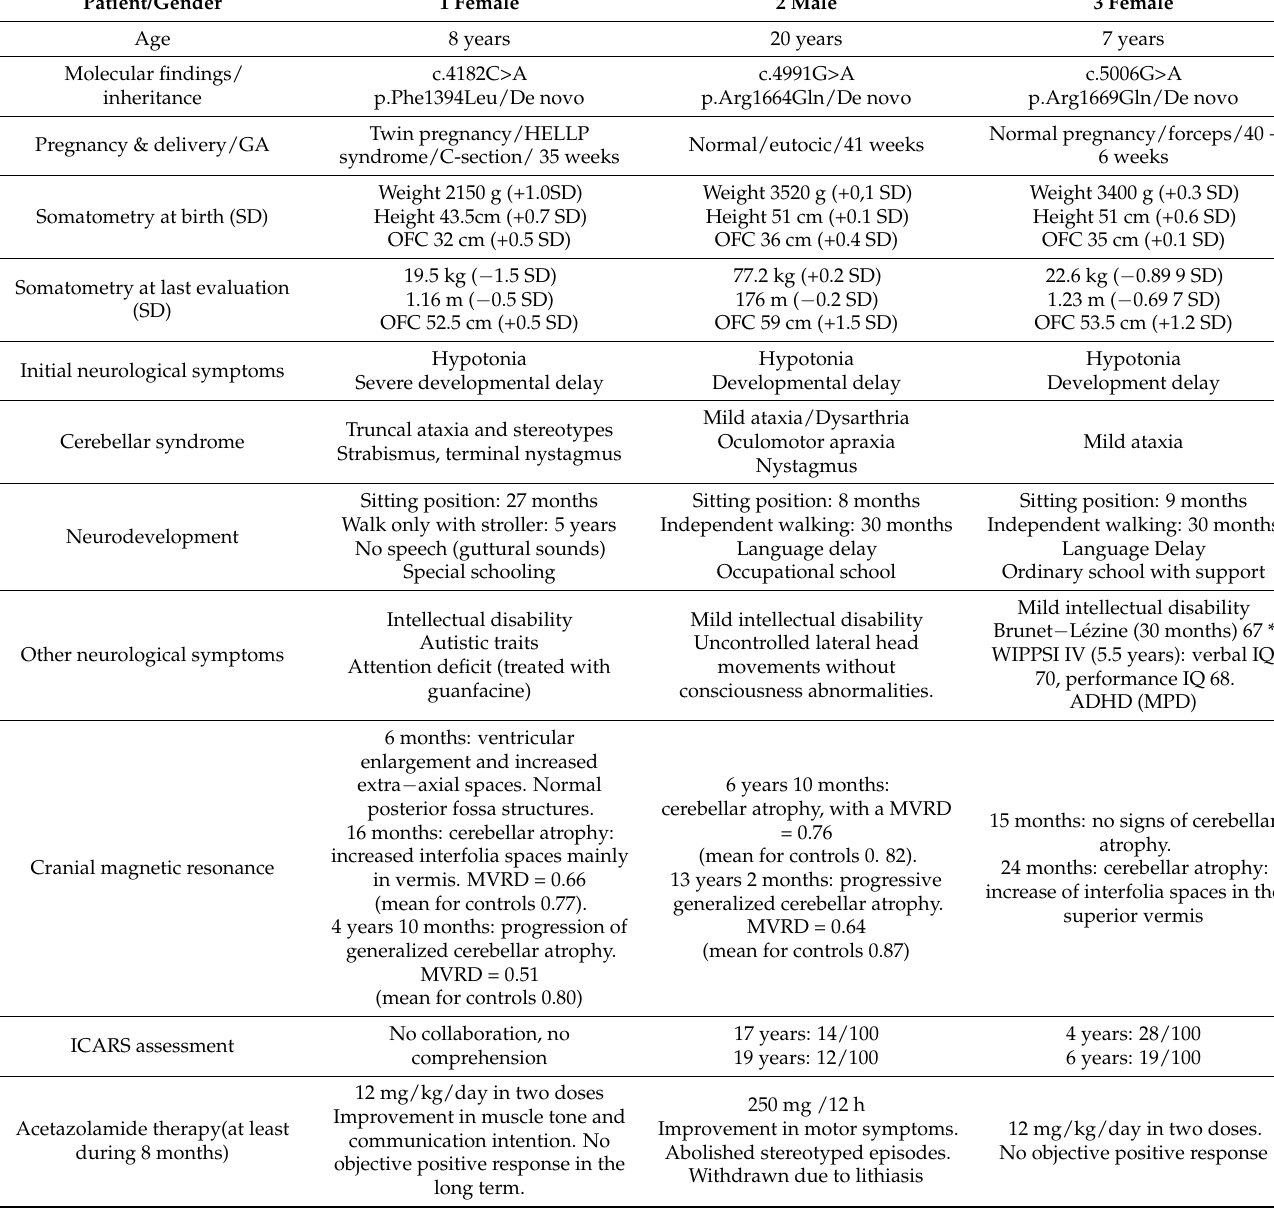
Table 1. GA: Gestational age; HELLP syndrome: hemolysis, elevated liver enzymes, low platelet count, related with pregnancy; SD: standard deviation; OFC: occipito-frontal circumference; WIPPSI: Wechsler Preschool and Primary Scale of Intelligence; ADHD: attention deficit and hyperactivity disorder; MPD: Methyphenidate; MVRD: Midsaggital vermis relative diameter. * Subscores: Language 77, socialization 80, coordination 75, postural